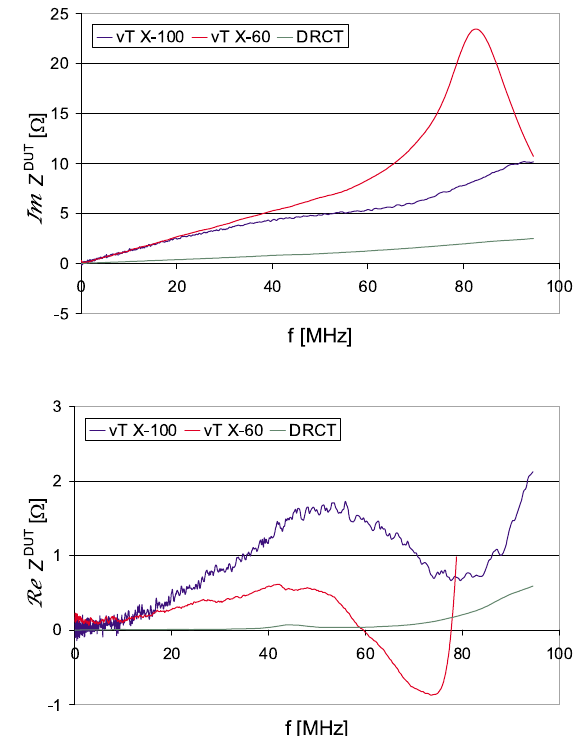
FIG. 11. (Color) Measured DUT impedance of the magnet with shorted